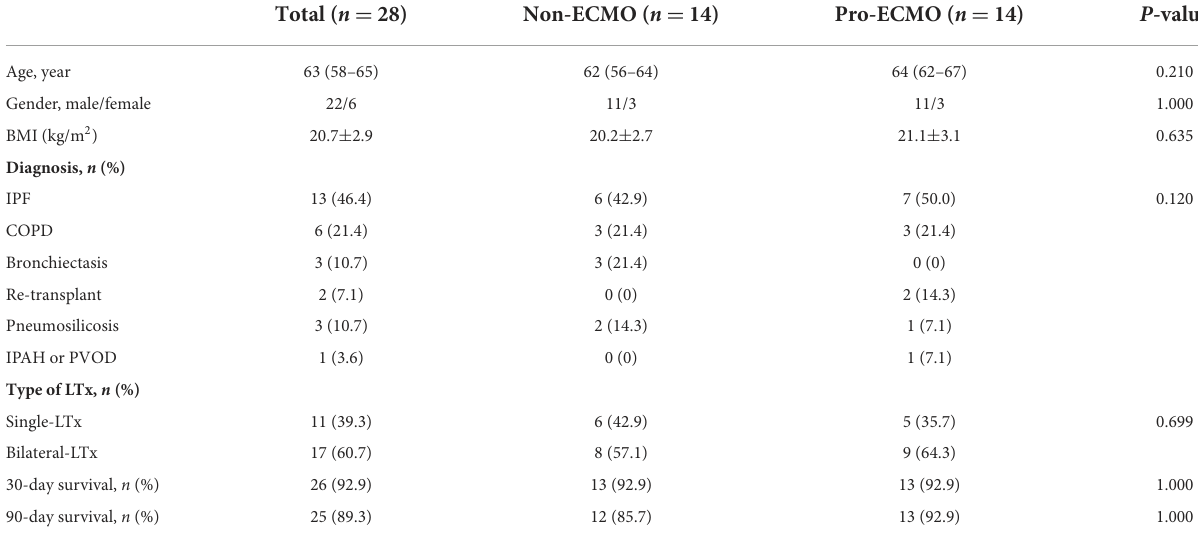
TABLE 3 Group characteristics of propensity-matched